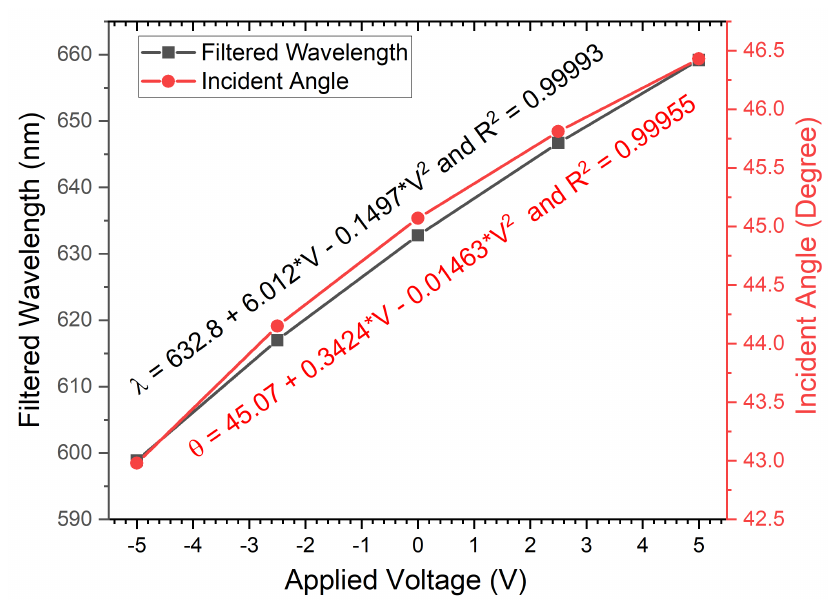
Figure 7. The comparative representation of the applied voltage on the filter wavelength at a constant incidence angle of 45.07 ◦ and on an incidence angle at a fixed filter wavelength of 632.8